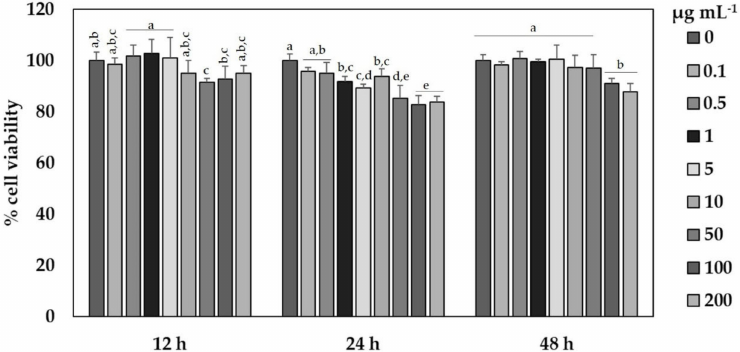
Figure 6. Time course of cytotoxic e ff ect on the viability of HaCaT keratinocytes of di ff erent concentrations (0–200 µ g extract mL − 1 ) of the optimized SFE extracts derived from Naxos (SFE-NX) by-products. Cell viability was determined using an MTT assay and expressed as percentages of the control. Values are given as the mean ± SD of six replicates. Di ff erent letters (a–e) denote statistically significant di ff erences within each time according to Tukey’s test ( p <